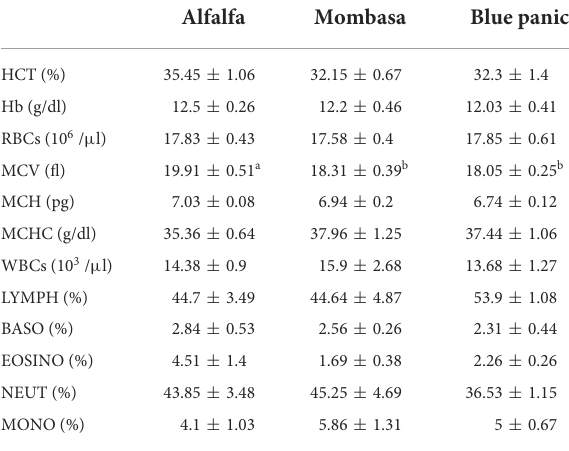
TABLE 2 Growth performance in growing goats fed alfalfa, Mombasa, or blue panic.